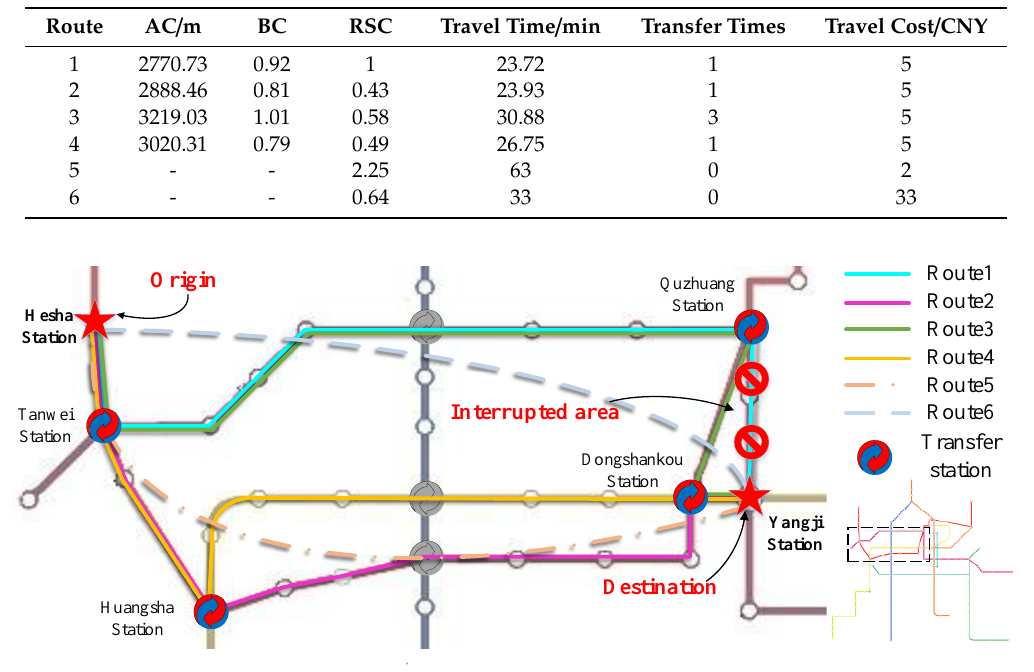
Figure 10. Available routes from HS station to YJ station.